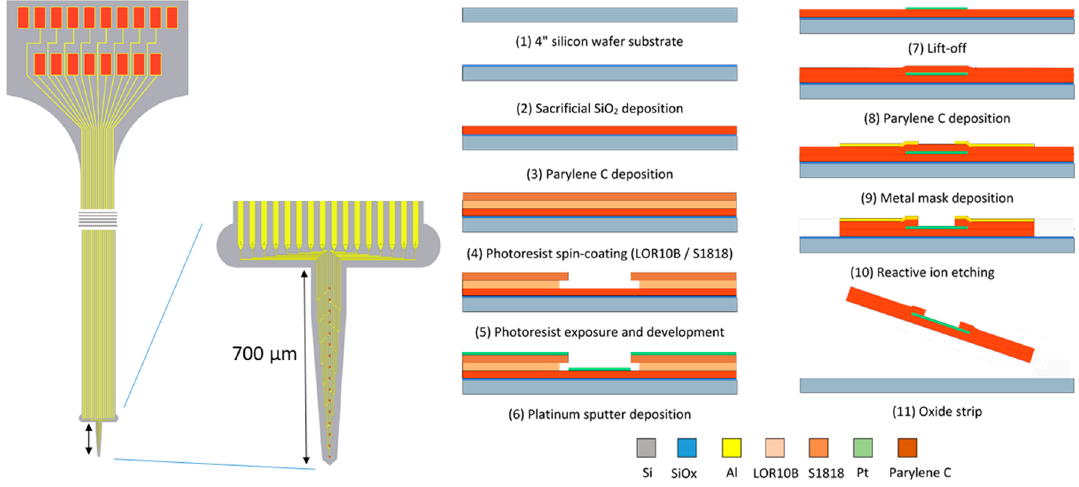
Figure 1. Electrode layout and microfabrication process.